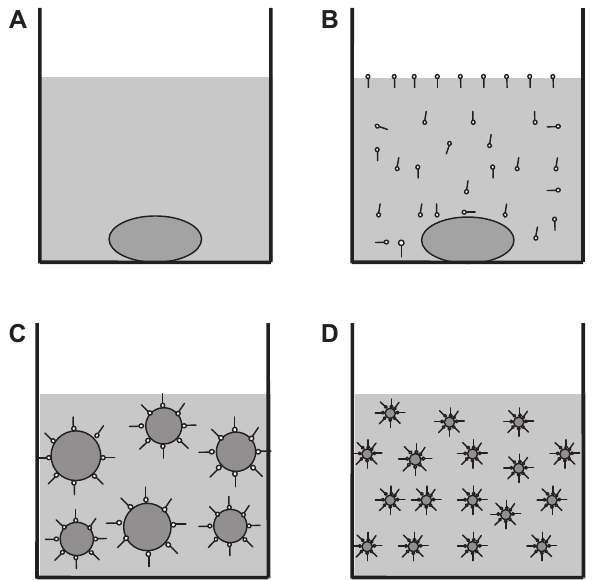
Figure 14 The schematic illustrating the formation of the metallic PCM fluids. (A) The PAO and molten metals are in the reaction vessel. These two liquids are immiscible and phase separate. (B) The polymer surfactant is soluble in the PAO and preferentially adsorbs at the interface. (C) The mixture is stirred using a magnetic stirrer, and the bulk molten metal breaks into microscale droplets. (D) The microscale emulsion is exposed to high-intensity ultrasonication until the PCM fluid is